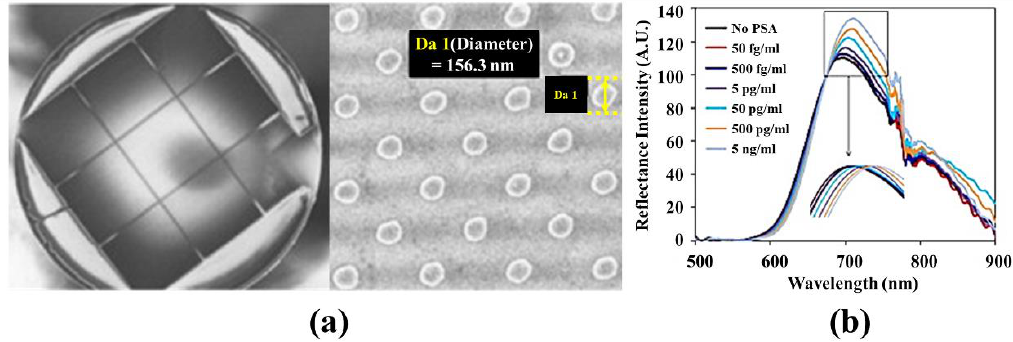
Figure 11. ( a ) Image of the end face of a miniaturized fiber-optic nanoprobe for label-free and highly-sensitive detection of free PSA (f-PSA) and a scanning electron microscopic image of gold nanodisks on the fiber-optic f-PSA sensor. ( b ) Reflectance intensities measured by the fiber-optic f-PSA sensor with varying concentrations of f-PSA. The reprint of figures in Sanders et al. [101] was permitted by Elsevier.